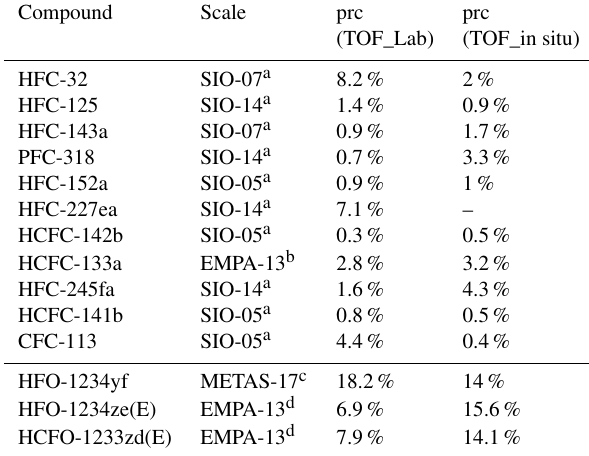
Table 1. System precision (1 σ ) of the investigated substances treated as a training set of the TOF-MS used for the weekly whole- air sampling (prc (TOF_Lab)) and of the TOF-MS used for the in situ measurements (prc (TOF_in situ)) and their calibration